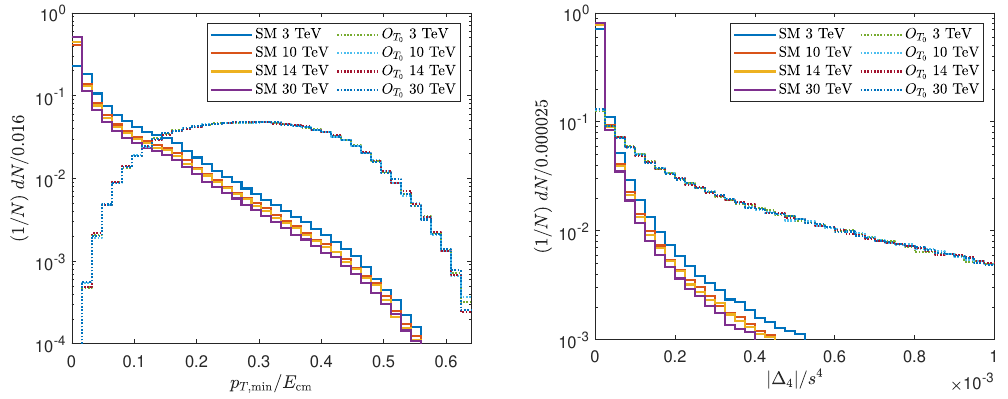
Figure 5 . The normalized distributions of p T, min /E cm (left panel) and | ∆ 4 | /s 4 (right panel) for SM and O T after the N γ i